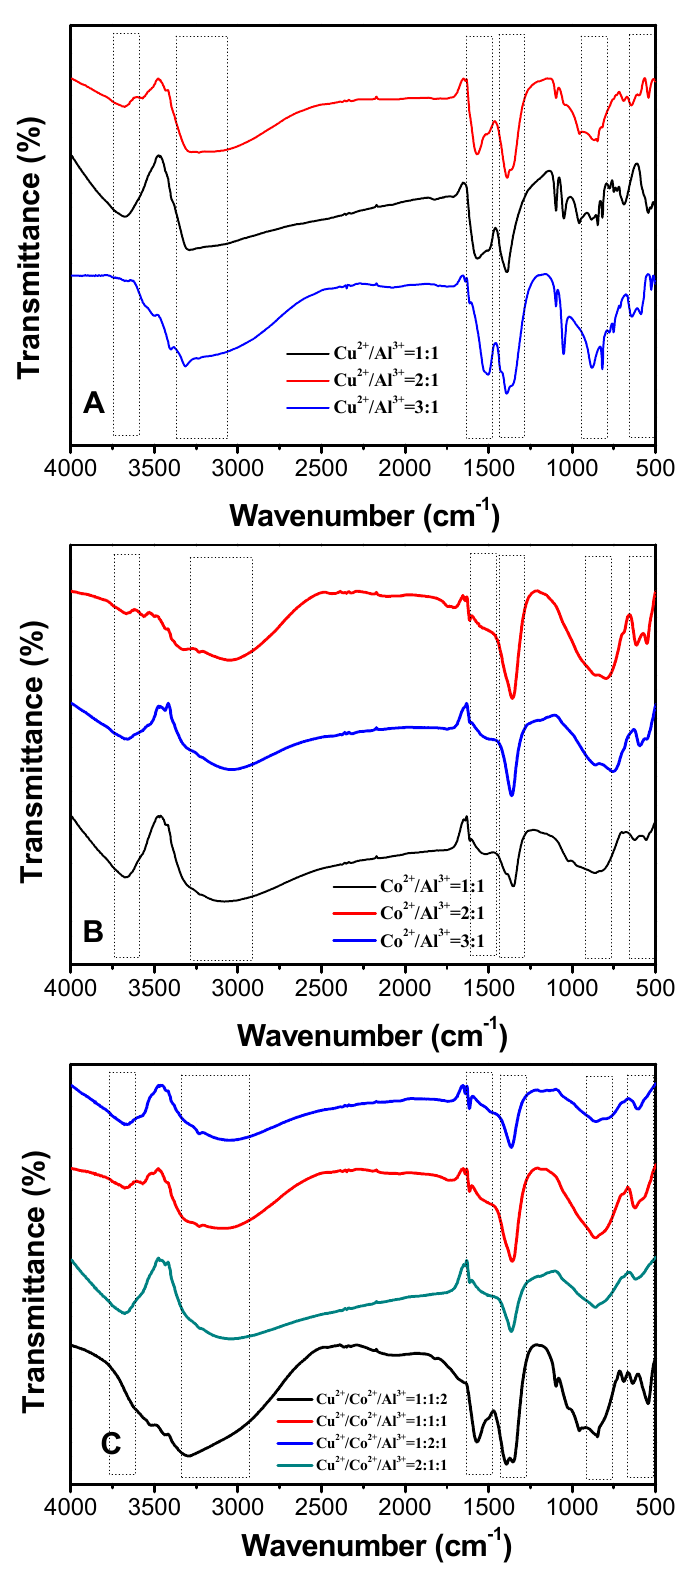
Figure 3. FT–IR spectra of the prepared HTLCs: ( A ) Cu/Al–HTLCs; ( B ) Co/Al–HTLCs; ( C ) Cu/Co/Al– Figure HTLCs.